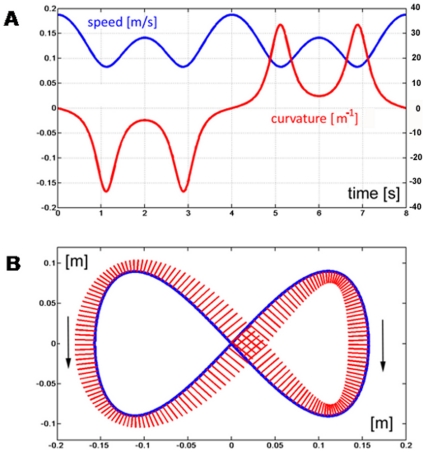
Characteristics of errorless trajectories.
A: Speed and curvature profiles of the target in the case of ideal, errorless tracking performance. The curvature scale (in m−1) is divided by 200. The correlation coefficient of the two curves is equal to 0.91. B: Pattern of force determined by the curl field, in the case of ideal, errorless tracking performance. The force vectors, perpendicular to the eight-shaped path and directed to the right of the instantaneous velocity vector, range between 8.3N and 18.3N.